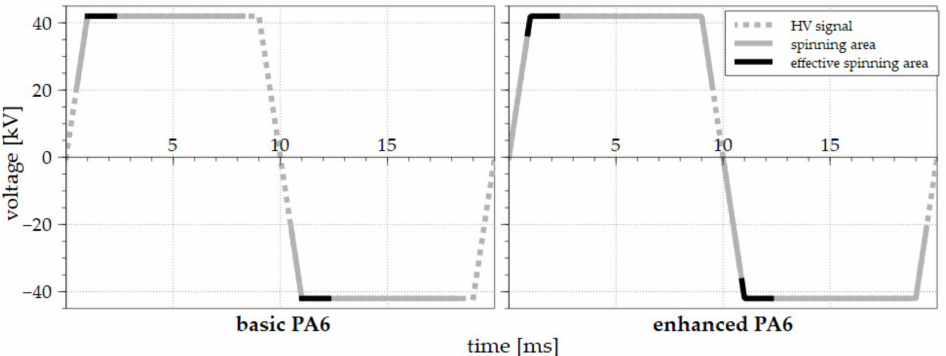
Figure 5. The AC electrospinning processes driven by the step change signal for the basic PA 6 solution ( left ) and the enhanced solution ( right ). The voltage signals are represented by the dotted gray lines, the spinning areas are shown as solid gray lines, and the effective electrospinning areas are highlighted by the solid black lines. The rising slope time was 1